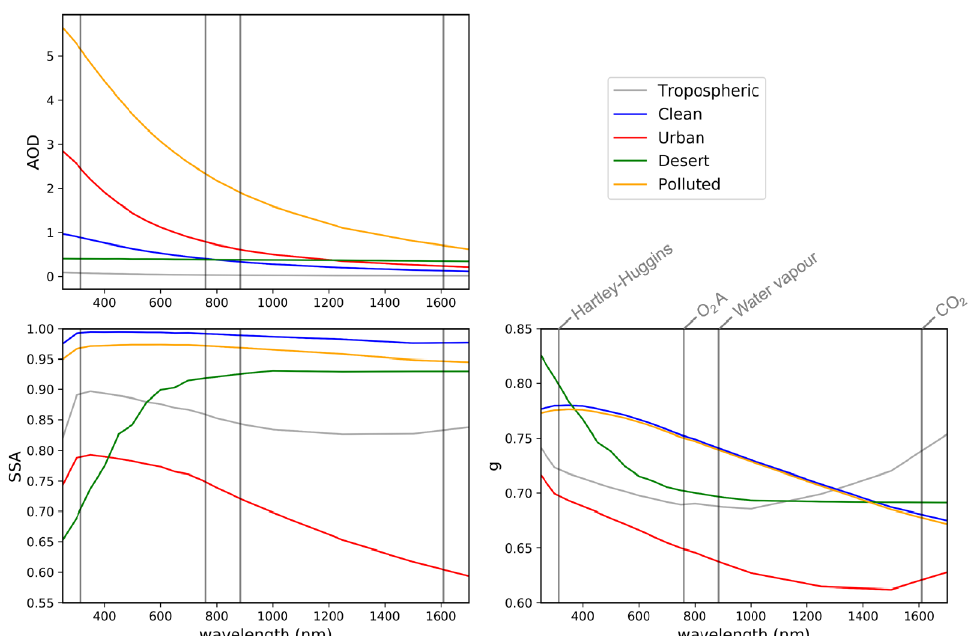
Figure 1. Overview of the optical properties (AOD, SSA and g) obtained from the OPAC database for the aerosol types: tropospheric, clean continental, urban, desert and polluted. Each vertical line corresponds with the middle wavelength of the spectral bands in order: Hartley–Huggins, O 2 A, water vapour and CO 2